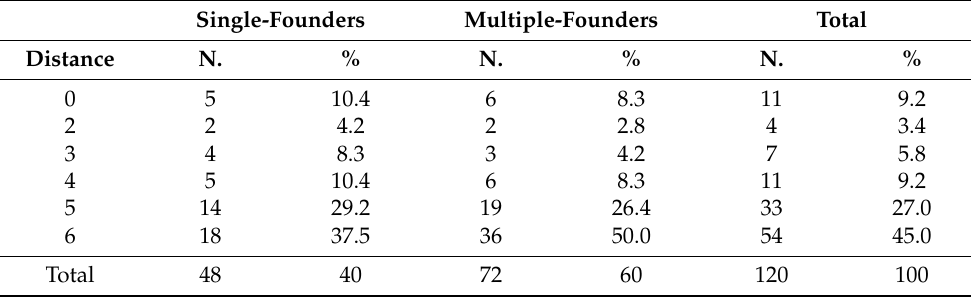
Table 5. Founders’ distance, single founders and